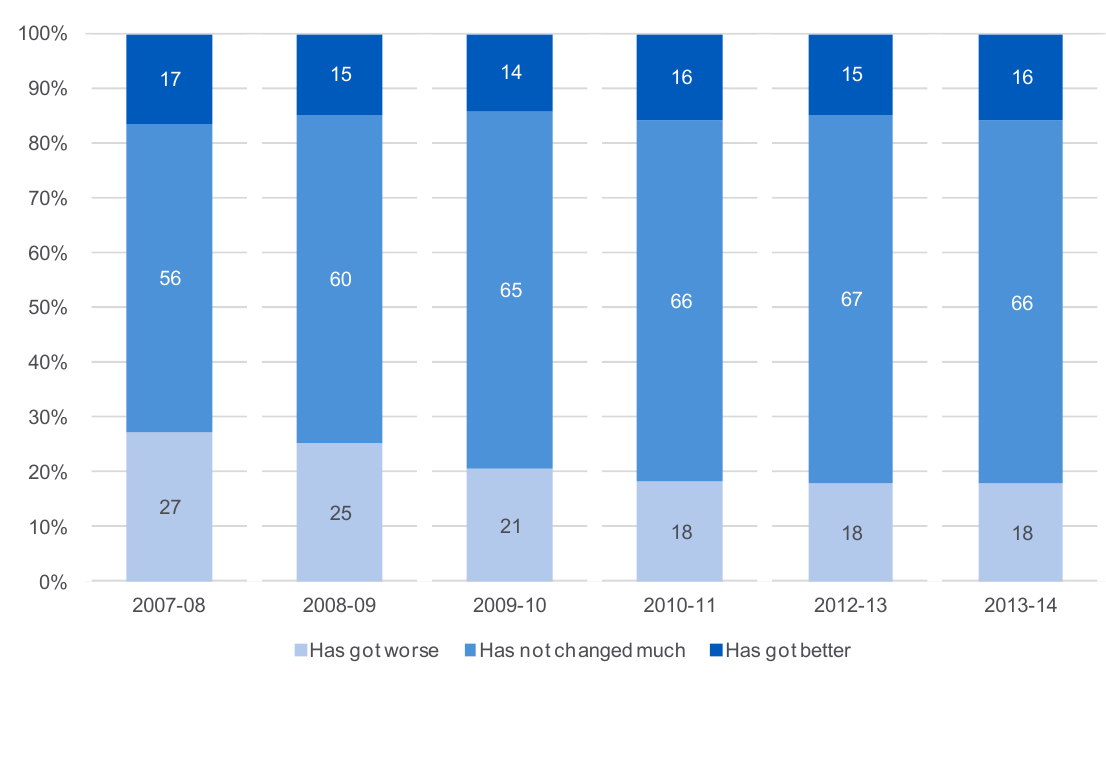
Figure 12: Proportion of people who think their local area has got better, worse or stayed the same over the last two years, 2007-08 to